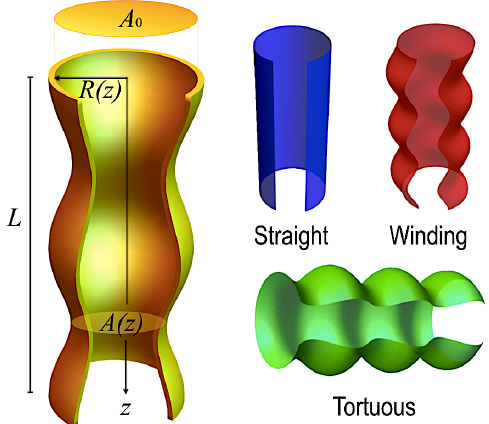
Figure 1. Geometry of an irregular tortuous pore of radius R ( z ) , transversal area A ( z ) and length L . Also shown are the three types of pores that will be used for numerical experiments. These experiments will consist on the study of the bulk and surface diffusion dynamics and its interplay with the adsorption–desorption and catalytic processes at the surface of the pore. The mathematical details of their geometries are summarized in Appendix A, in particular the values of the geometric parameters used in simulations are provided in Table